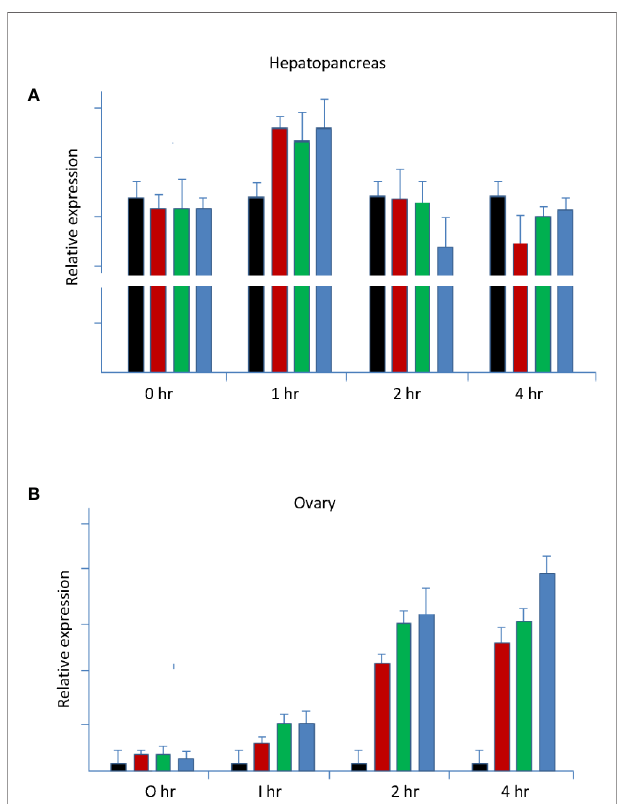
FIGURE 9 | Neuroendocrine regulation of LvVg1 expression in in vitro cultured hepatopancreas and ovary (N = 5). The tissues were incubated with explants of the eyestalk optic nerve (Es; red bar), brain (Br; green bar), or thoracic ganglion (Tg; blue bar). Hepatopancreas (A) and ovary fragments (B) were incubated in a medium containing one of the above tissues. The control tissues (black bar) were incubated without addition of the nervous tissues. Samples were taken at the 0, 1, 2, and 4 h time points following incubation. Q-PCR was performed to determine expression levels of the LvVg1